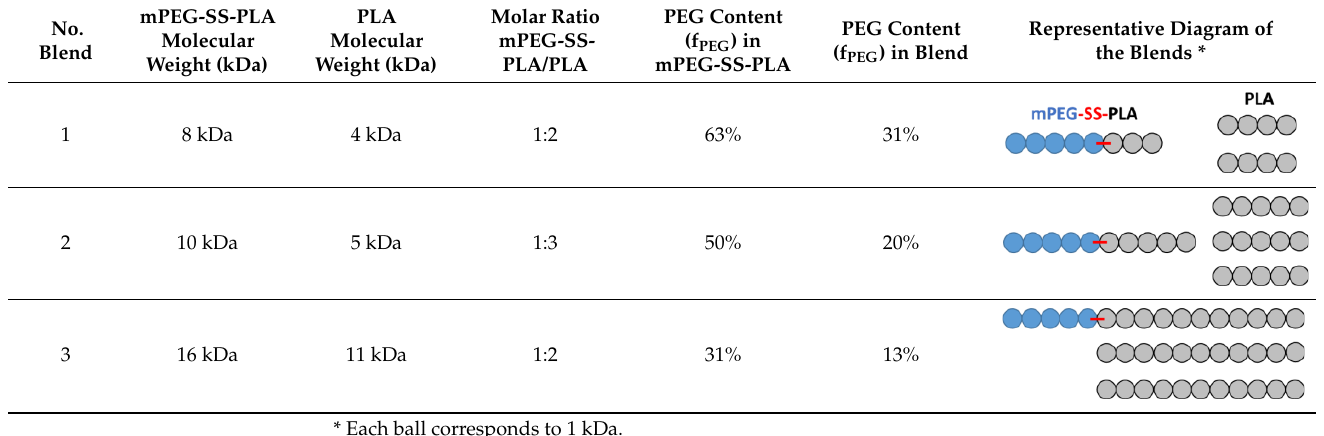
Table 1. Molecular characteristics of each blend.